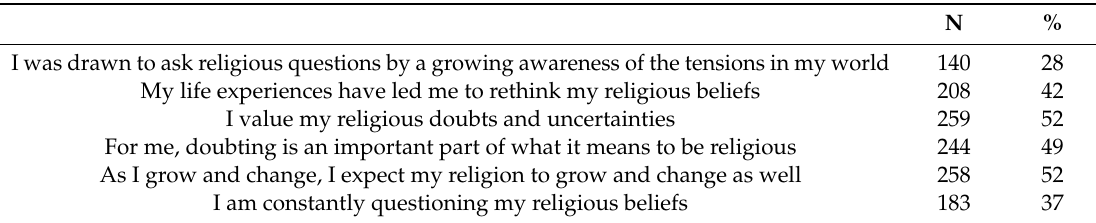
Table 14. Quest religious